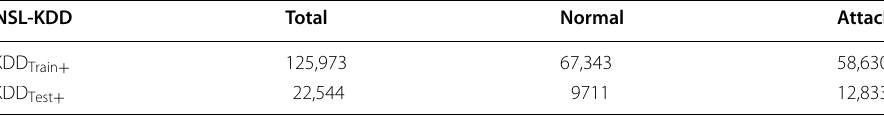
Table 2 Data distribution of NSL‑KDD